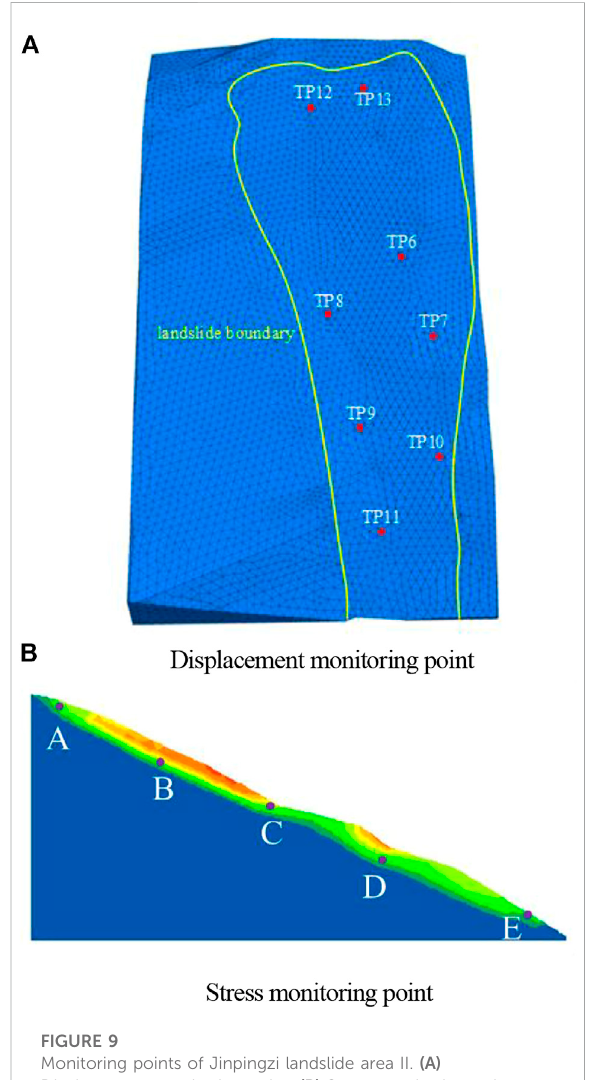
FIGURE 9 Monitoring points of Jinpingzi landslide area II. (A) Displacement monitoring point. (B) Stress monitoring